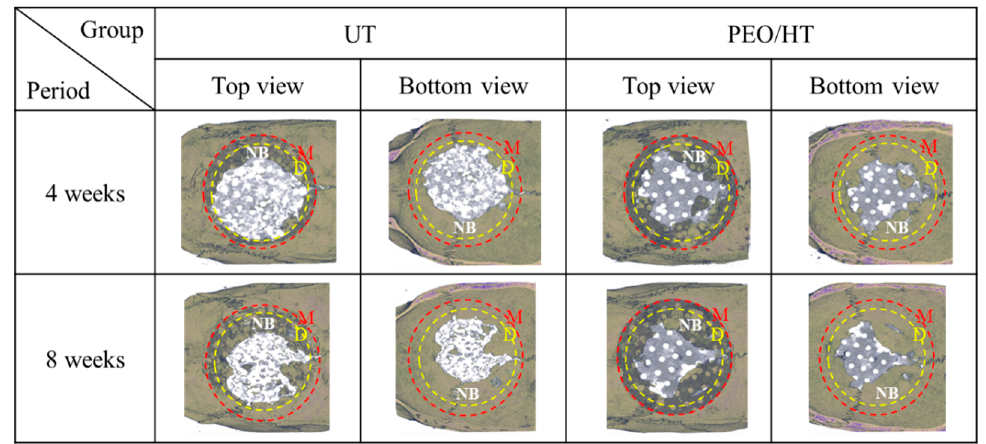
Figure 5. Micro-CT images of the degraded Mg meshes and new bone formed into rat calvarial defects after in vivo tests at four weeks and eight weeks. The yellow-dotted line signifies the area of the calvarial defect formed initially in surgery, demarcating the internal new bone and external old bone. The red-dotted line indicates the outer line of the Mg mesh. (Yellow circle D = defect; red cycle M = magnesium mesh; NB represented the newly formed bone inside the yellow circle).